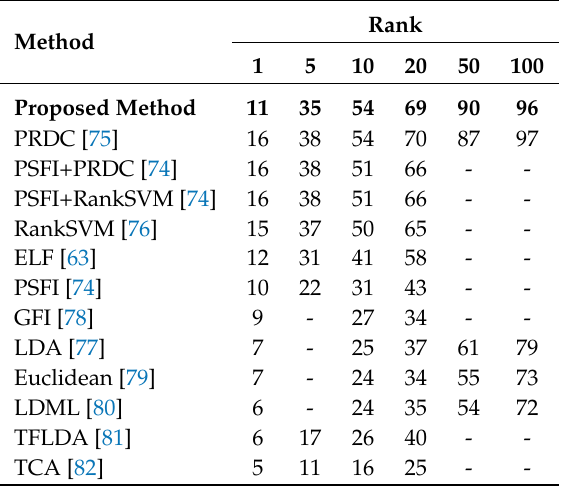
Table 7. Comparison of CMC rates (in [%]) of Re-Id methods on VIPeR dataset, ‘-’ indicates no result was